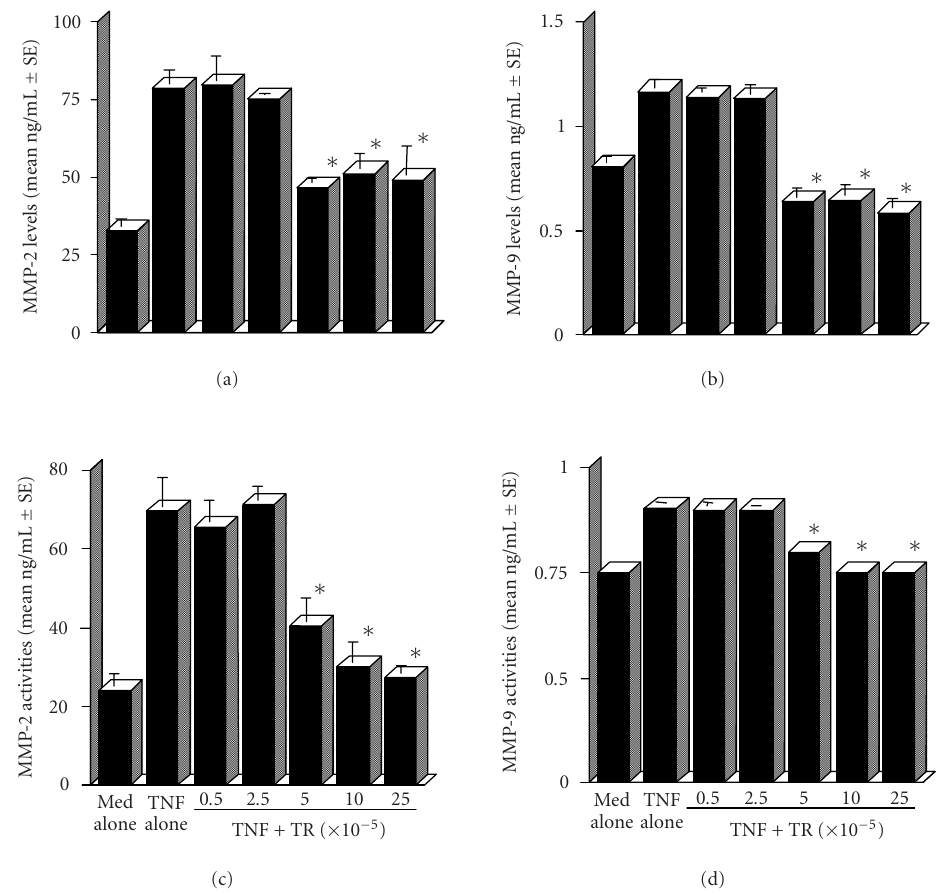
Figure 2. Influence of tranilast (TR) on the production of MMP-2 and MMP-9 from nasal fibroblasts in response to TNF- α stimula- tion and on their activities. Cells were stimulated with 10 . 0ng/mL TNF in the presence of various concentrations of TR for 24 hours. Data are expressed as the mean ng/mL ± SE of five di ff erent subjects. (a) MMP-2 levels; (b) MMP-9 levels; (c) MMP-2 activities. (d) MMP-9 activities. ∗ means significant ( P < . 05) compared with TNF